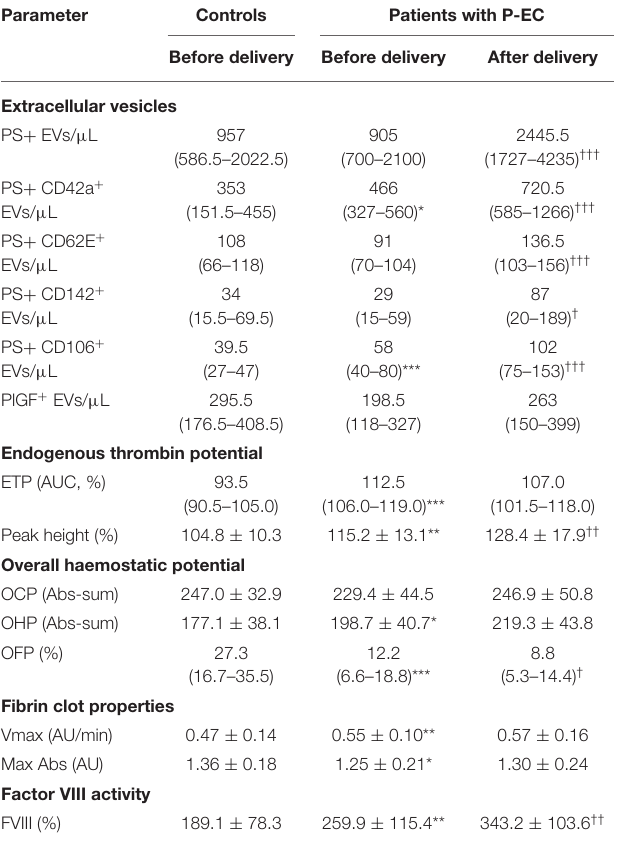
TABLE 2 | Concentration of circulating extracellular vesicles and levels of investigated haemostatic parameters in patients with P-EC before and after delivery ( n = 30) and in controls ( n = 36).